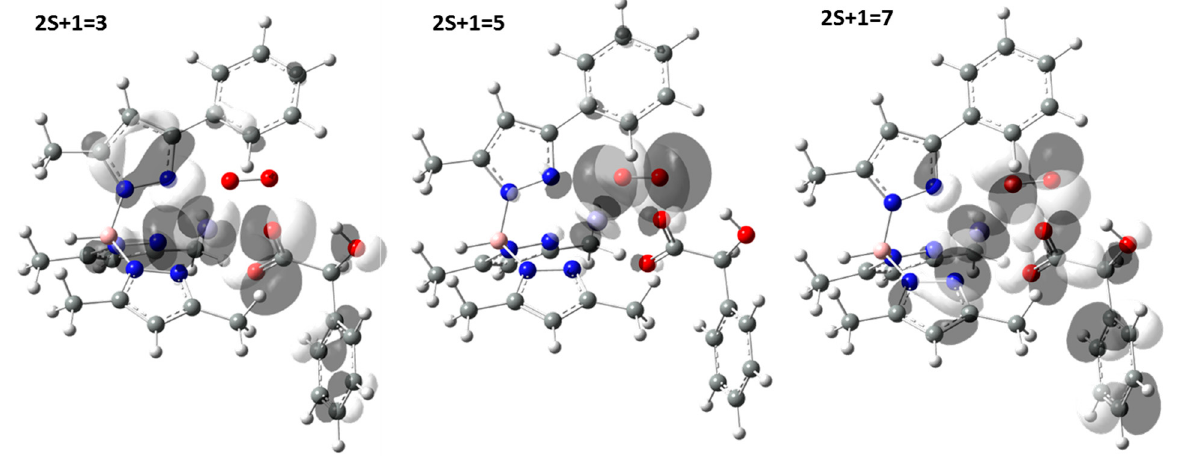
Figure 3. Highest occupied molecular orbital (HOMO) composition of a -O 2 adduct, in the triplet, quintet and septet states.